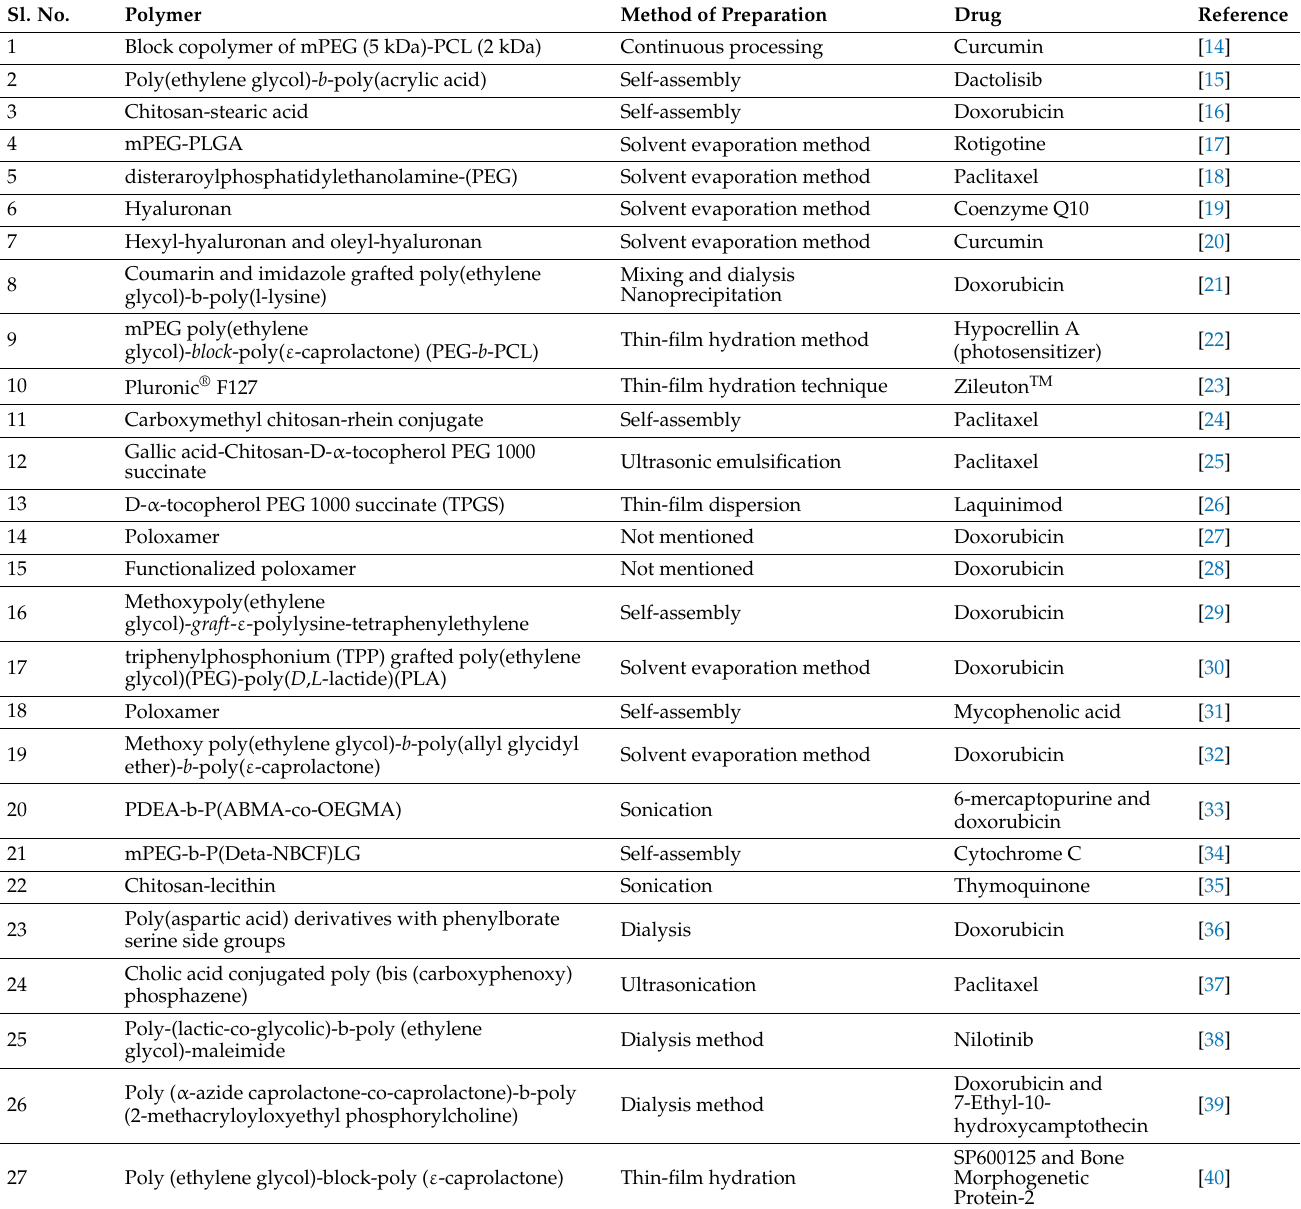
Table 1. Different types of polymers used for micelle fabrication and their methods of